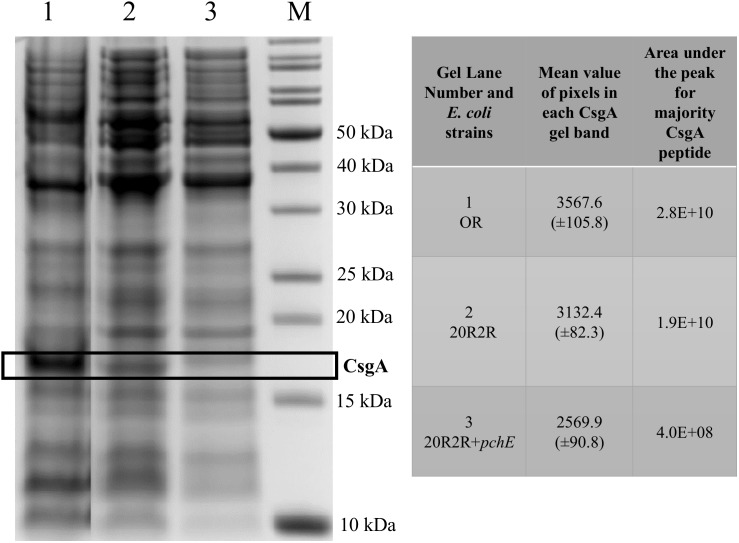
A 12% Bis-Tris polyacrylamide gel containing formic acid treated whole cell extracts and the resulting data derived from the CsgA containing band. E. coli strains grown on T-medium agar at 37°C; OR (lane 1), 20R2R (lane 2), 20R2R+pchE (lane 3), molecular weight standards (lane M). Box marks the location of the bands containing the CsgA protein. The mean value of pixels present in the individual CsgA bands were visualized and measured by a Gel DocTM EZ Imager and Image LabTM (Bio-Rad) program. The area under the peak for the major peptide (NSDLTITQHGGGNGADVGQGSDDSSIDLTQR [triple charged]) produced from tryptic digestion of the CsgA containing band were measured by mass spectrometry.